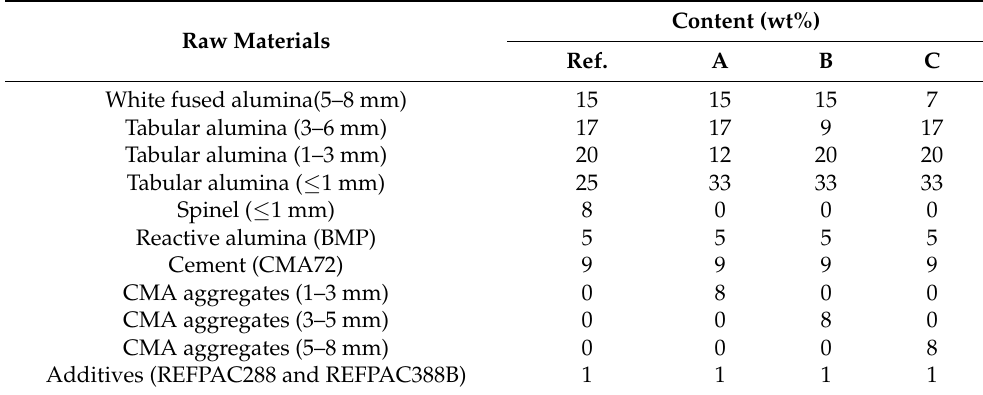
Table 1. Compositions of alumina-spinel refractory castables. Raw